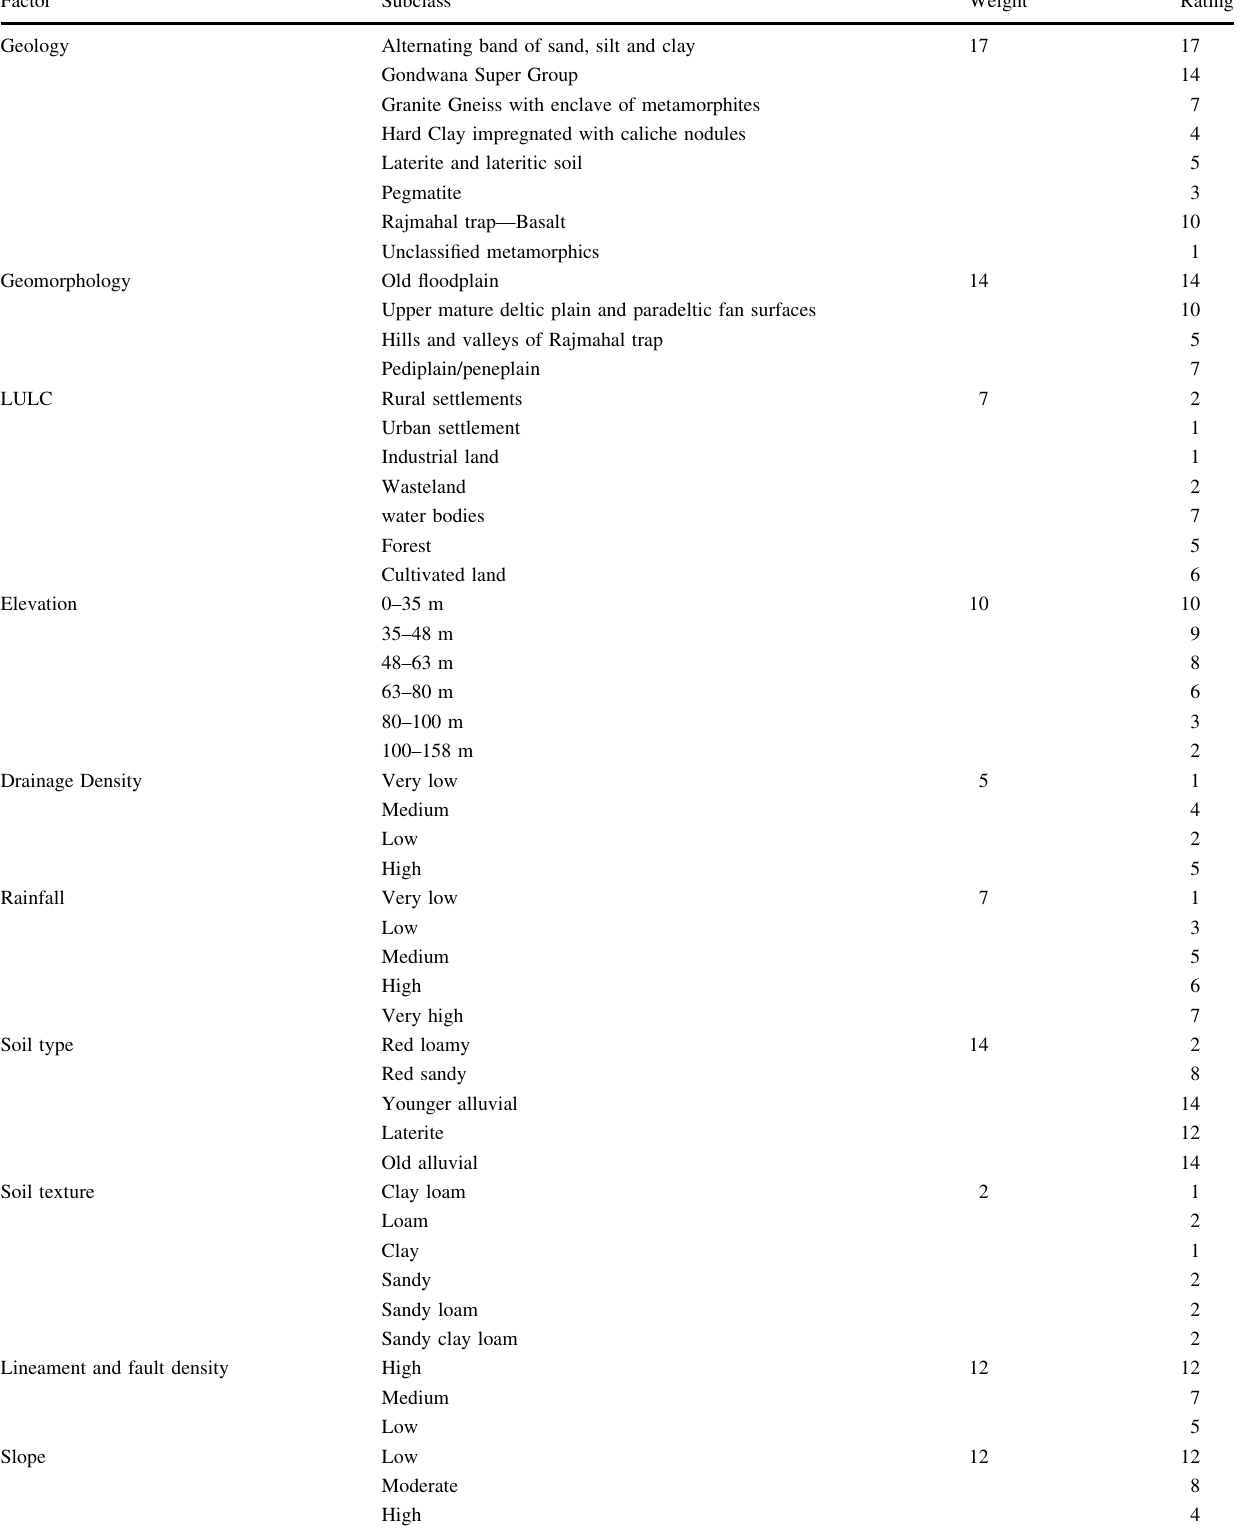
Table 2 Classification of weighted factors influencing the potential zones in the study area